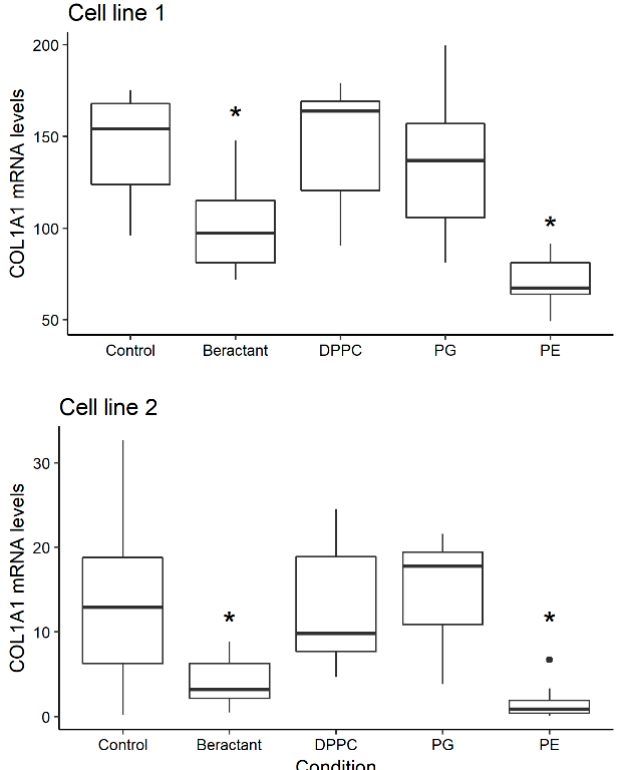
Figure 1. Effect of dipalmitoilphosphatidylcoline (DPPC), phosphatidylglycerol (PG) and phosphatidylethanolamine (PE) on collagen expression in lung fibroblasts. Cells from passages 5–10 were placed in 6 well plates and when confluence was reached, culture medium was substituted with serum-free F-12 for 24 h. Beractant (500 µ g · mL − 1 ) and corresponding phospholipids were diluted in F-12 without serum and cells were incubated for 48 h. Controls were grown for the same time in F-12 without serum. DPPC: 200 µ g · mL − 1 ; PG: 50 µ g · mL − 1 ; PE: 50 µ g · mL − 1 . The figure represents the pooled data of two independent experiments in two cell lines. Asterisks denote significant differences ( p < 0.05, ANOVA with post-hoc Dunnett test against the control).